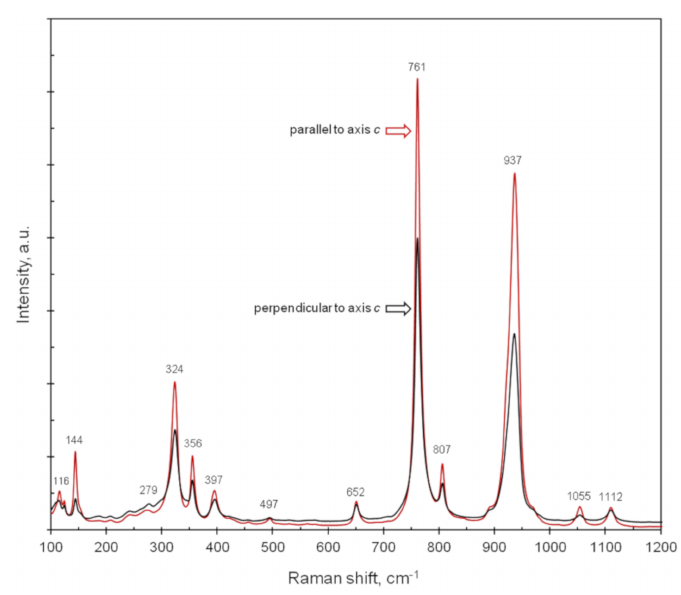
Figure 12. Oriented Raman spectra for single crystal of rippite.